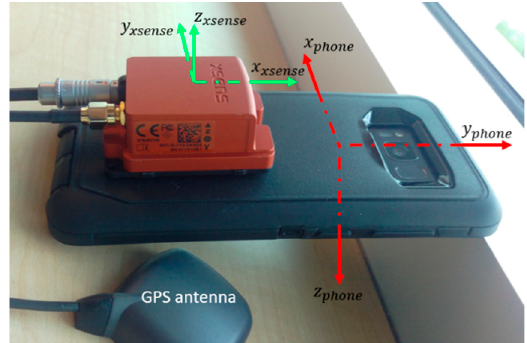
Figure 18. Testing device configuration.